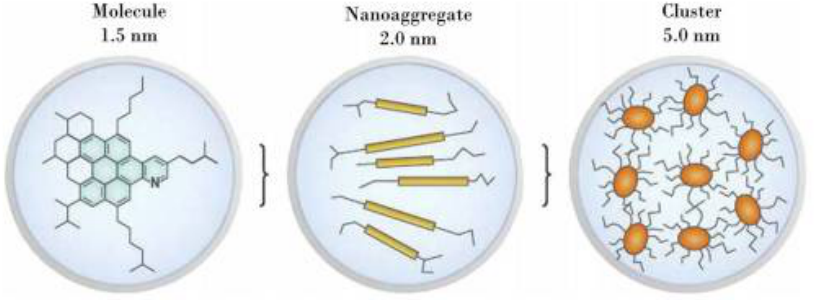
Figure 1. The mechanism of formation of aggregates and clusters of asphaltenes, based on the modified Yen model [16].